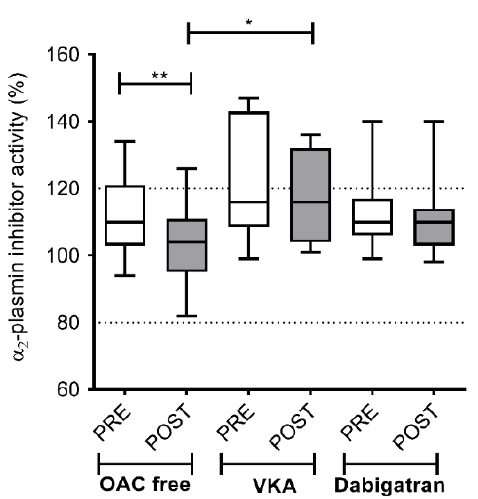
Figure 4. Left atrium α 2 - plasmin inhibitor activity levels before and after cryoballoon ablation procedure in AF patients on various pre-procedural anticoagulation strategies. Box and whisker plots indicate median, interquartile range, and total range. Dashed lines indicate lower and upper limit of reference interval (80–120%). PRE (empty bars): pre-ablation, POST (solid bars): post-ablation, OAC: oral anticoagulant, VKA: vitamin K antagonist. * p < 0.05, ** p < 0.01. Statistical significance remained essentially the same when assessed after controlling for the effect of covariates associated with selection (age, sex) between treatment groups.